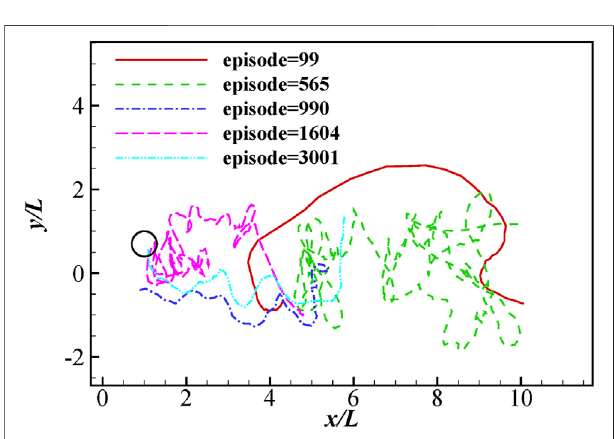
FIGURE 5 | The traces of the head during different learning